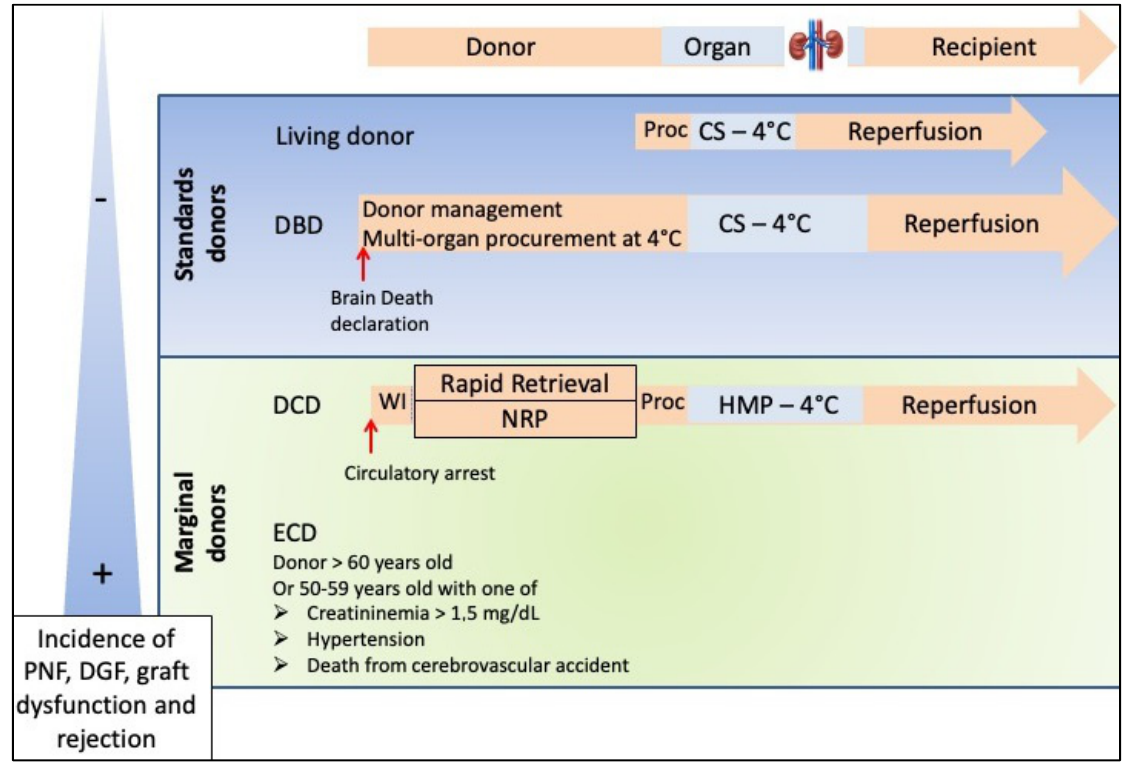
Figure 2. Graft course according to donor type (e.g., kidney). Abbreviations: extended criteria donors (ECDs); deceased donors after circulatory arrest (DCDs); brain-dead donors (DBDs); delayed graft function (DGF); primary non-function (PNF); static conservation at 4°C (SC); normothermic regional perfusion (NRP); warm ischemia (WI); hypothermic conservation on perfusion machine (HMP). Figure adapted from Franzin et al [12].